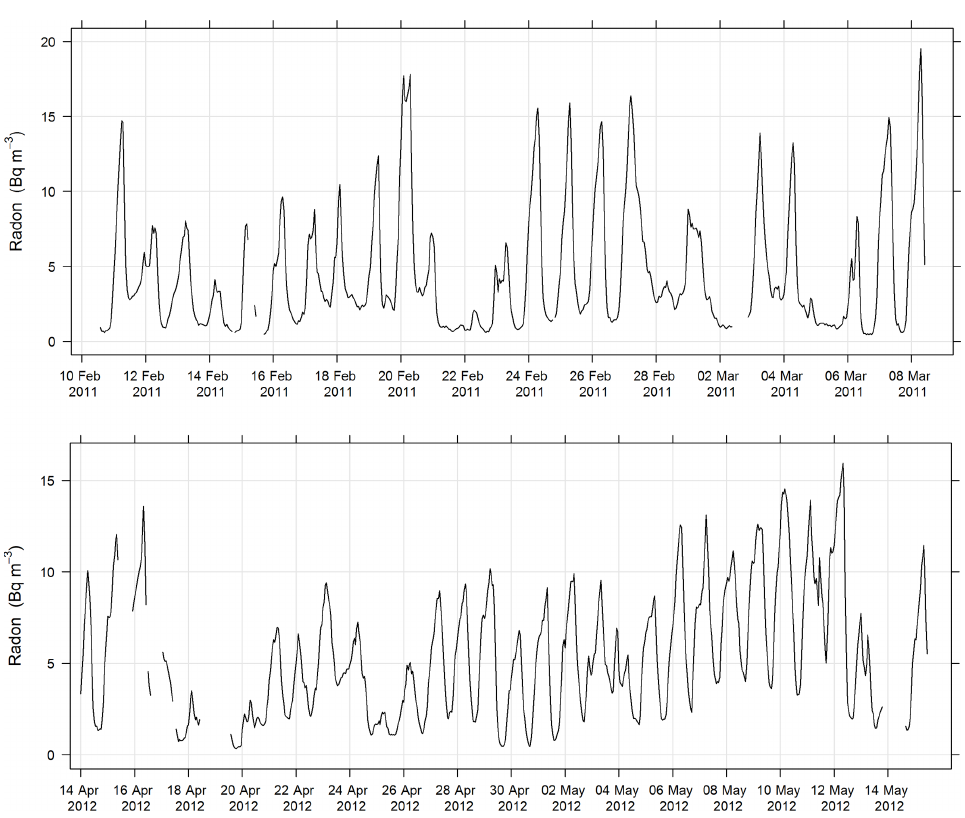
Figure 6. Time series radon concentrations during SPS-I and